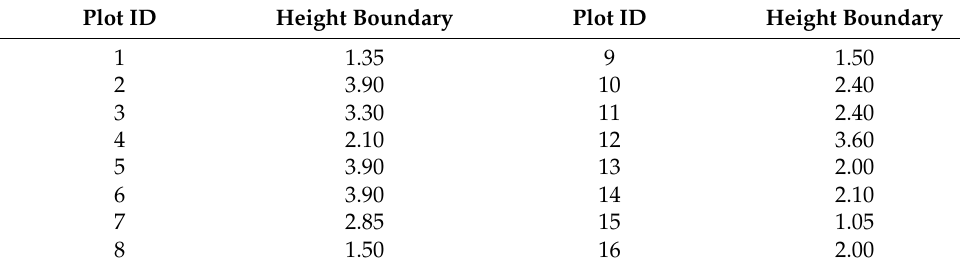
Table 2. Height boundaries at the plot level (unit: m).